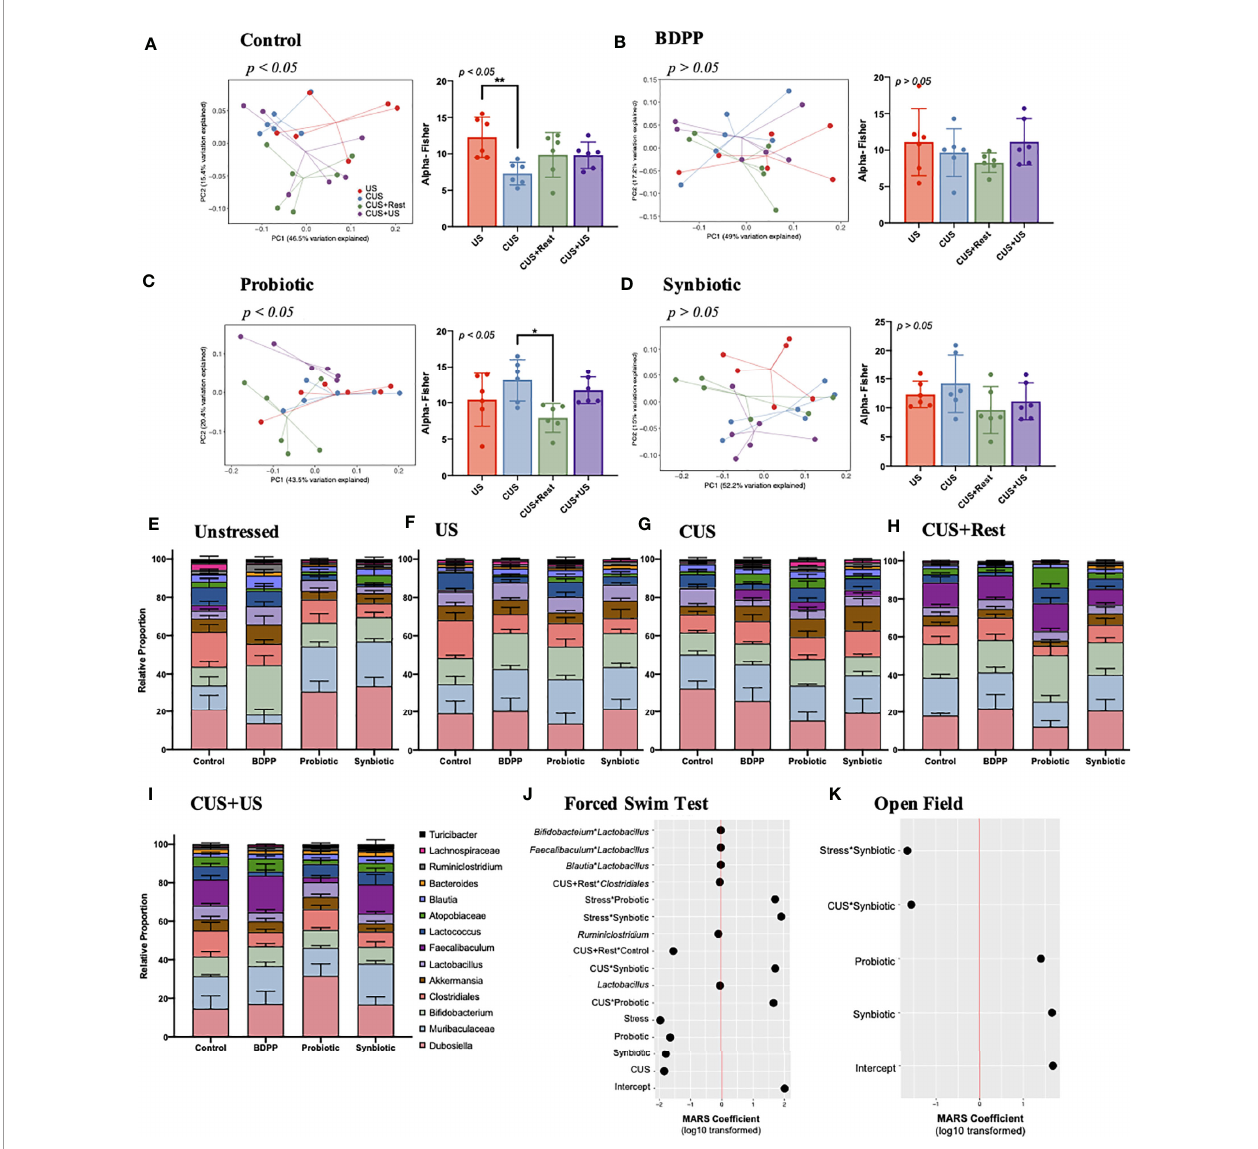
FIGURE 3 | Chronic and recurrent stress induced variations in the gut microbiota in response to synbiotic treatment. 16S V4 metagenomic sequencing of the gut microbiota following chronic and recurrent stress and treatment with variations in genera across all timepoints in the CUS protocol: US, CUS, CUS+Rest and CUS+US. Variation in community structure was assessed with permutational multivariate analyses of variance (PERMANOVA) between groups (beta diversity) with visualization of the data using Principal Coordinates Analysis (PCoA) with the lines representing the distance of each individual to the centroid. The alpha diversity calculated as the Fisher ’ s Alpha test following (A) stressed vehicle control, and stress with (B) BDPP, (C) Probiotic and (D) Synbiotic. Statistical signi fi cance is marked by *p < 0.05 and **p < 0.01. Variations in the gut microbiota over time, within treatment group can be found in Figure S3 . Variations in the 14 most abundant genera with respect to treatment is shown in (E) unstressed vehicle controls, (F) US, (G) CUS, (H) CUS+Rest and (I) CUS +US with statistical differences outlined in Figure S4 . Results from the MARS algorithm show the interactions of gut microbiome and study covariates predicting (J) forced swim test and (K) open fi eld test. The x-axis depicts the signed log10 transformed absolute value of the term coef fi cient in the MARS model. Note that the hinge function was removed for simplicity of visualization. Each group contains n = 6 mice (the same mice used for RNA/protein studies) +/- SEM individuals while signi fi cance determined with one-way ANOVA with Tukey ’ s posthoc analysis. Statistics for the b -diversity is as outlined in material and methods